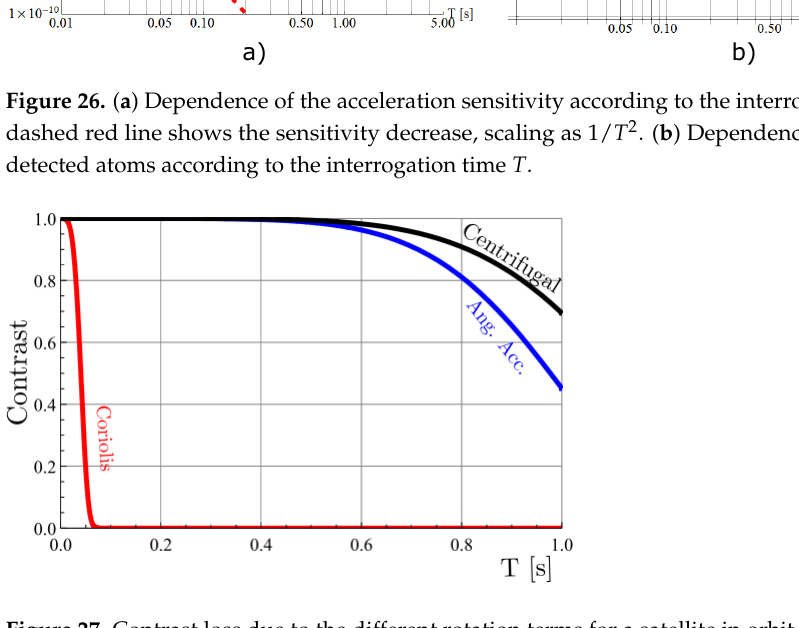
Figure 27. Contrast loss due to the different rotation terms for a satellite in